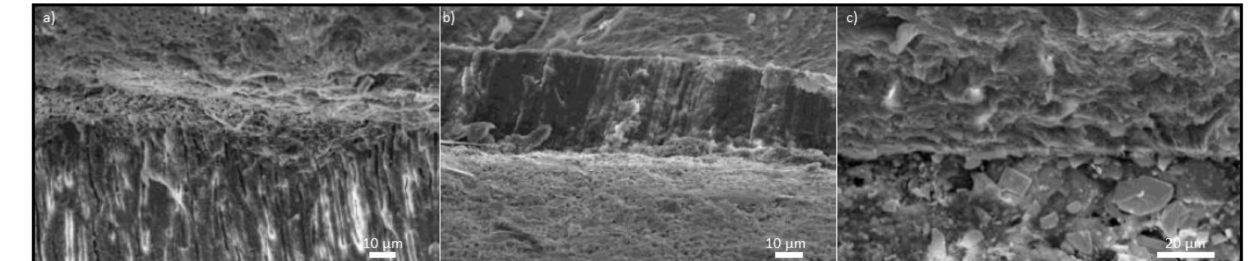
Figure 22. Connection of the root dentine with resilon as a filling material using thermoplastic condensation using the THC technique, covered with a thin intermediate layer of sealant (SEM): ( a ) connection structure with a visible cross-section of dentinal tubules along their axis transverse to the axis of the root canal; ( b ) close connection with the exposed course of the dental tubules; ( c ) bonding the resilon and the interlayer of the sealant to the visible flake structure.